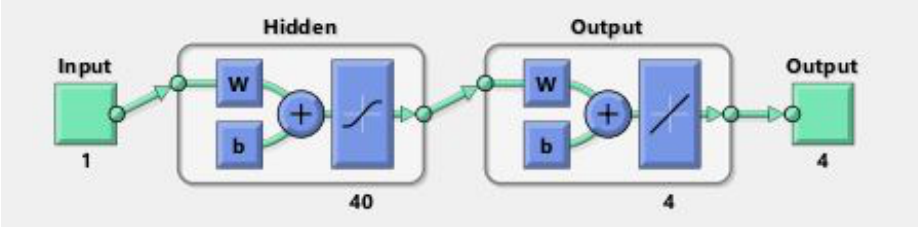
Figure 3. Showing the model which is generated through nftool command in matlab